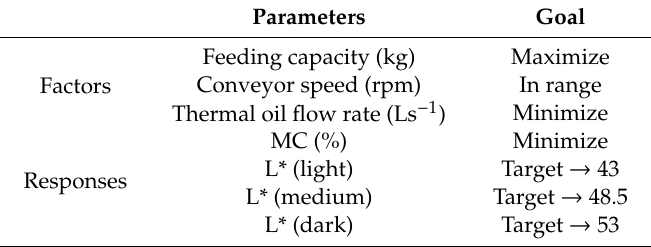
Table 1. Optimization criteria for Continuous Solar Roaster